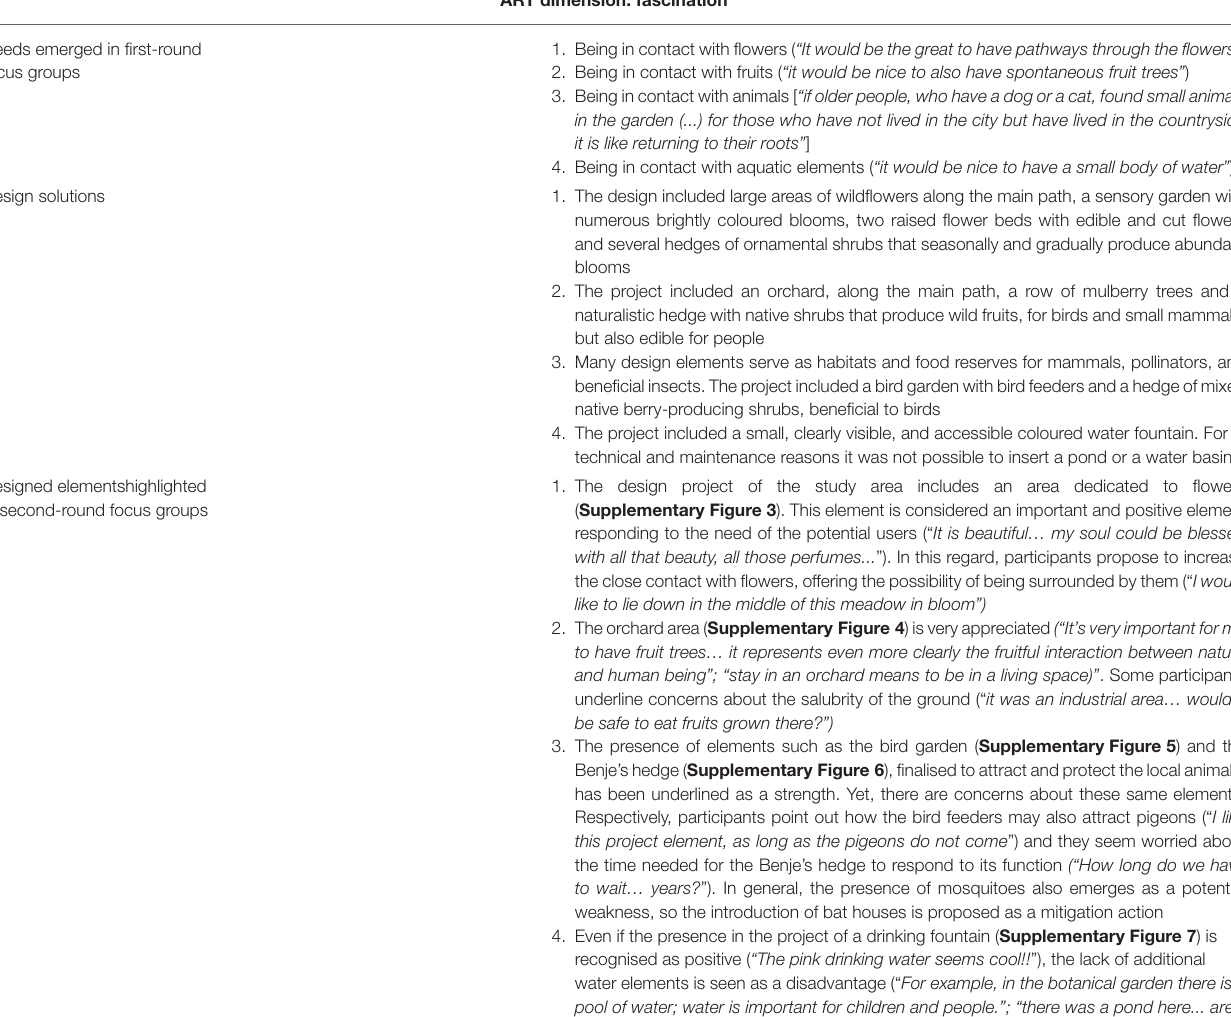
TABLE 3 | Comparison of the needs and reactions of the participants to the design proposal (ART,